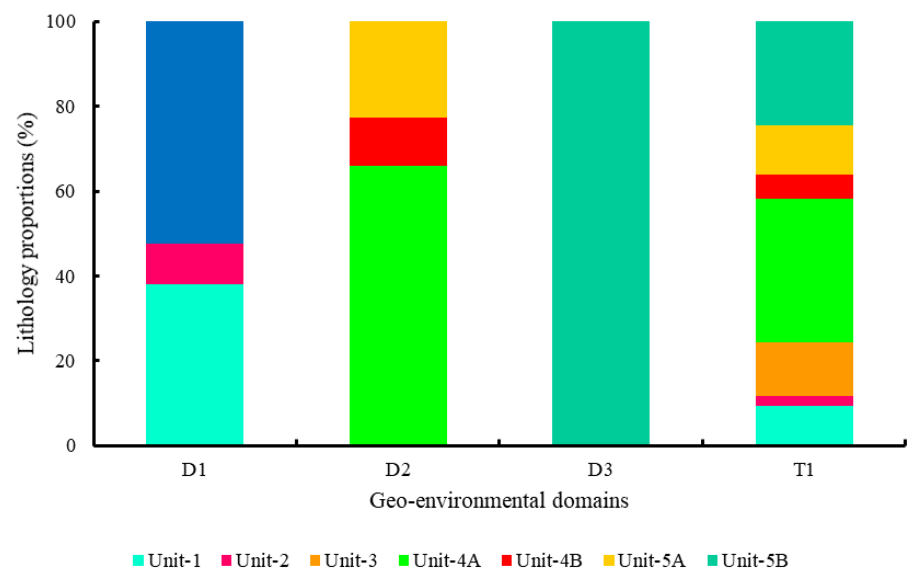
Figure 1. Blend samples prepared to assess geochemical interactions among lithological units within geo-environmental domains (the size of the boxes represent blending proportions). D1. the mafic domain, D2. the dacite domain, D3. the intermediate domain, T1. the all-embracing domain, Unit-1. andesitic basalt unit, Unit-2. Fe-Ti rich basalt, Unit-3. andesite, Unit-4A. dacite, dacitic tuff, dacitic intrusions, and quartz-feldspar porphyry type 1, Unit-4B. alkaline andesite and alkaline andesitic tuff, Unit-5A. dacite, dacitic tuff, dacitic intrusions, and quartz-feldspar porphyry type 2, Unit-5B. alkaline andesite and alkaline andesitic tuffs.